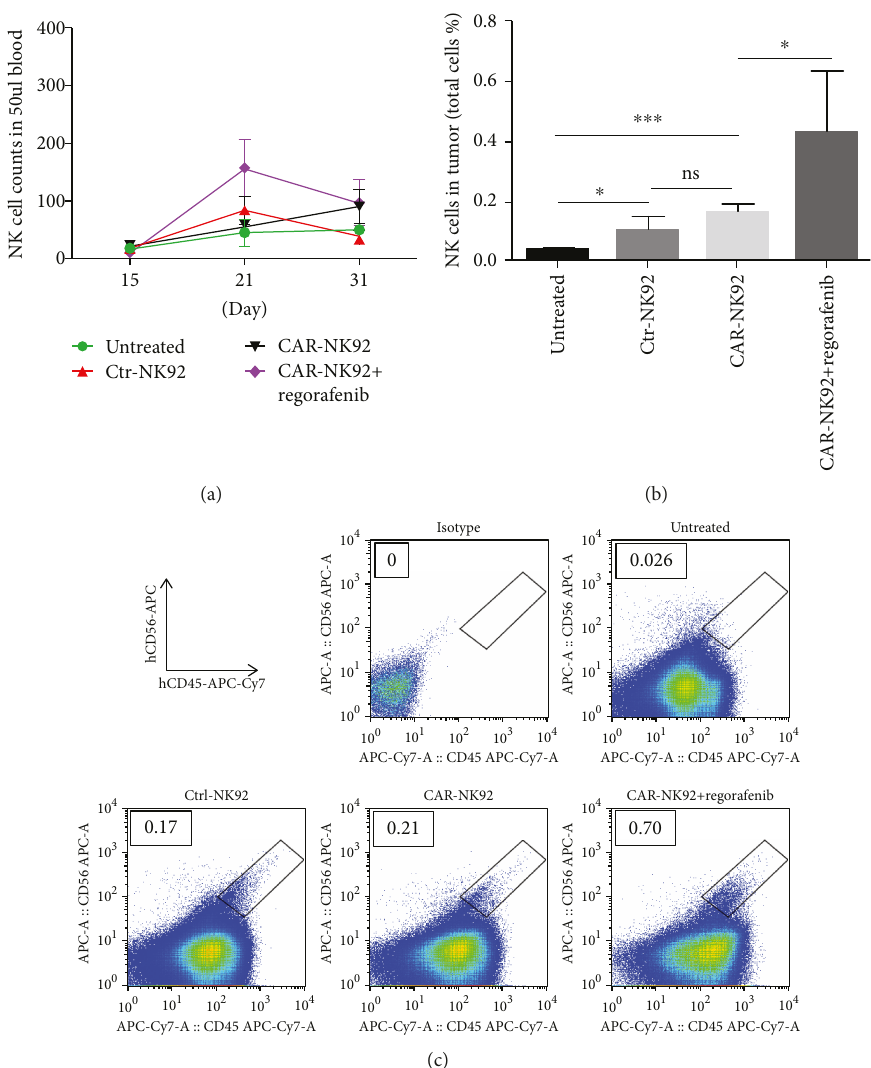
Figure 5: Persistence of NK-92 cells in vivo . (a) Continuous persistence of NK-92 cells in the blood of mice by FACS. (b) The quantitative analysis results of NK-92 cells in tumors by FACS. (c) Representative results of NK-92 cells in tumors shown in (b). NK-92 cells were stained with APC-conjugated anti-hCD56 and APC-Cy7-conjugated anti-hCD45 antibodies in all experiments. ∗ p < 0 05 ; ∗∗∗ p < 0 001 ; ns: not signi fi